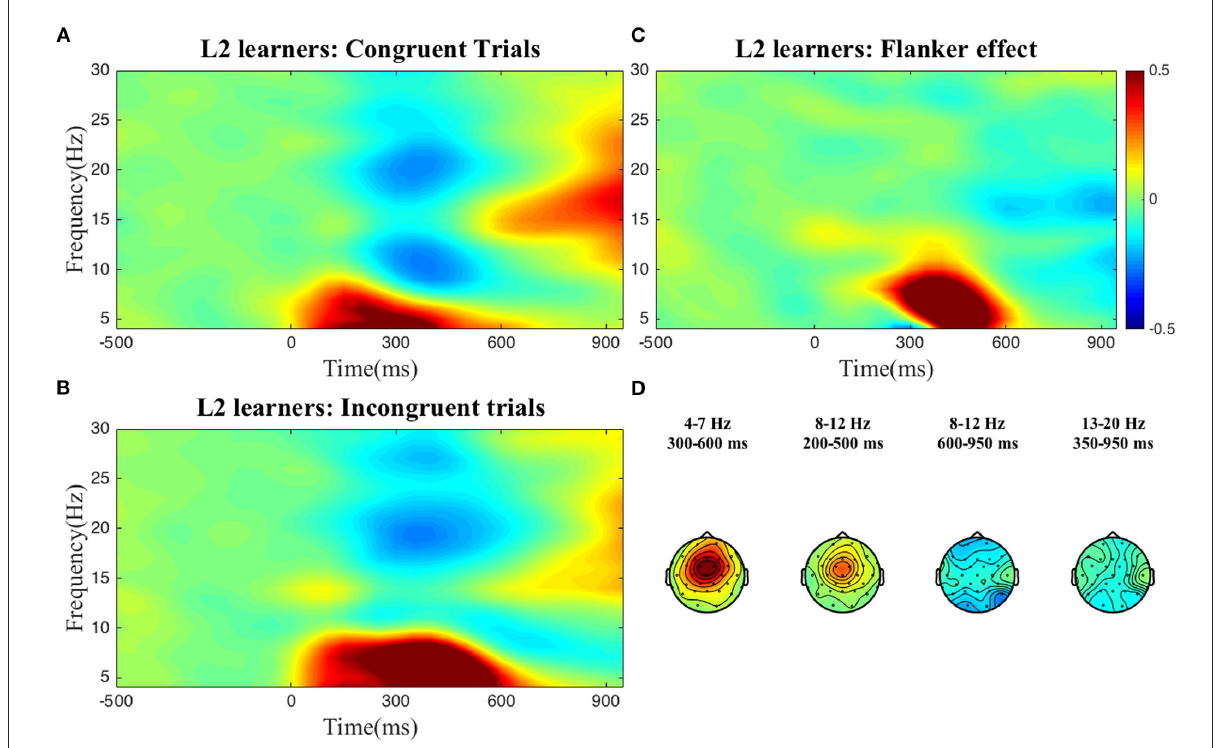
FIGURE1 TFRs for the L2 learner group. Averaged time-frequency representations of individual conditions (A,B) and the Flanker effect (C) for the L2 learners for 4–30Hz in a representative electrode, Cz and topographical plots (D) of the Flanker effect for the time-frequency clusters of interest. The Flanker effect was computed by subtracting power in the Congruent condition from power in the Incongruent condition. The color bar applies to both single electrode and topographical plots and indicates relative power